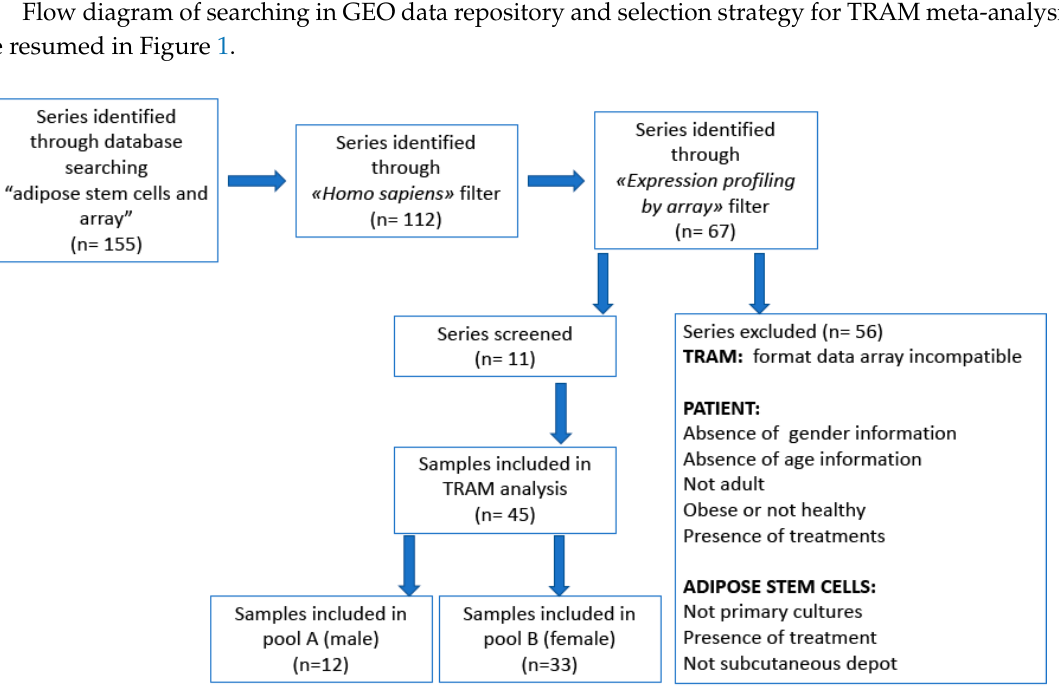
Figure 1. Flow diagram of data searching and selection strategy for Transcriptome Mapper (TRAM) meta-analysis.